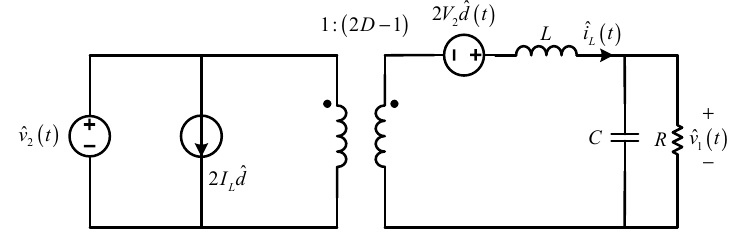
Figure 6. Small-signal AC equivalent circuit of bidirectional DC-DC converter.